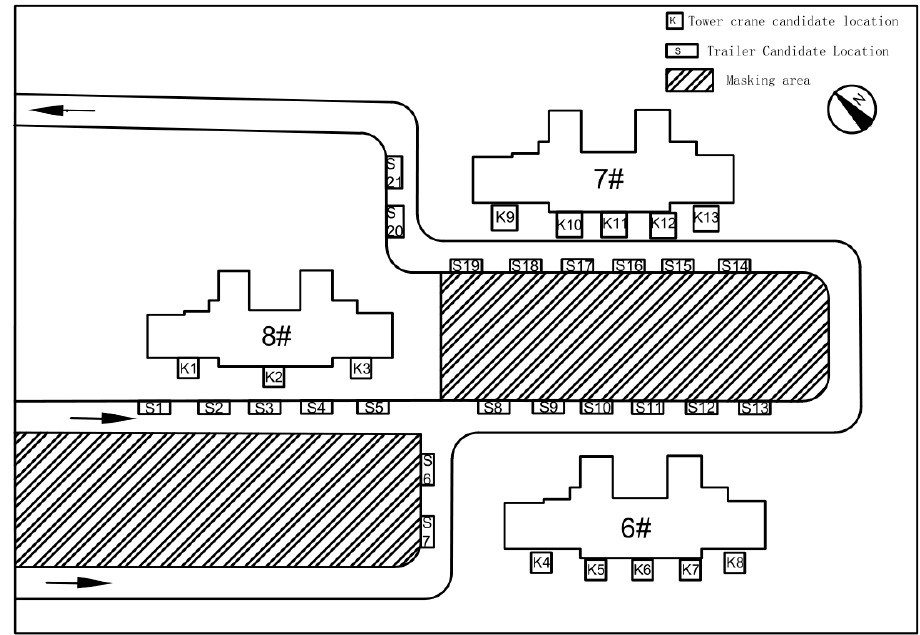
Figure 4. High-rise modular housing in Area 2.